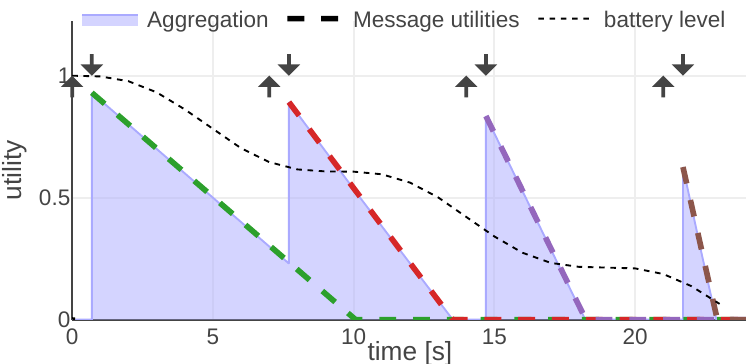
Figure 2. A batt and U batt functions plotted for an instance of the given mission. c (cid:13) 2019 IEEE. Reprinted, with permission, from